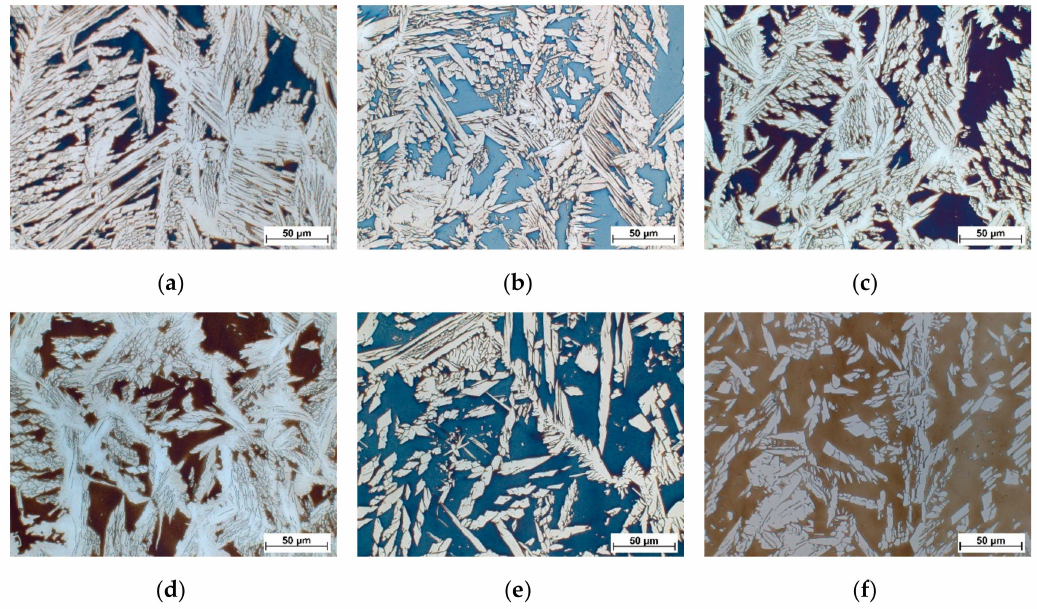
Figure 8. Micrographs of the welded wall structures produced with di ff erent mixing ratios at 500x magnification, taken in layer 10, etching: Beraha II, blue / brown: ferrite, white: austenite ( a ) 100% G 22 9 3 N L, ( b ) 90,9% G 22 9 3 N L + 9,1% GZ 22 5 3 L, ( c ) 83,3% G 22 9 3 N L + 16,7% GZ 22 5 3 L, ( d ) 76,9% G 22 9 3 N L + 23,1% GZ 22 5 3 L, ( e ) 23,1% G 22 9 3 N L + 76,9% GZ 22 5 3 L, ( f ) 100% G 22 5 3 N